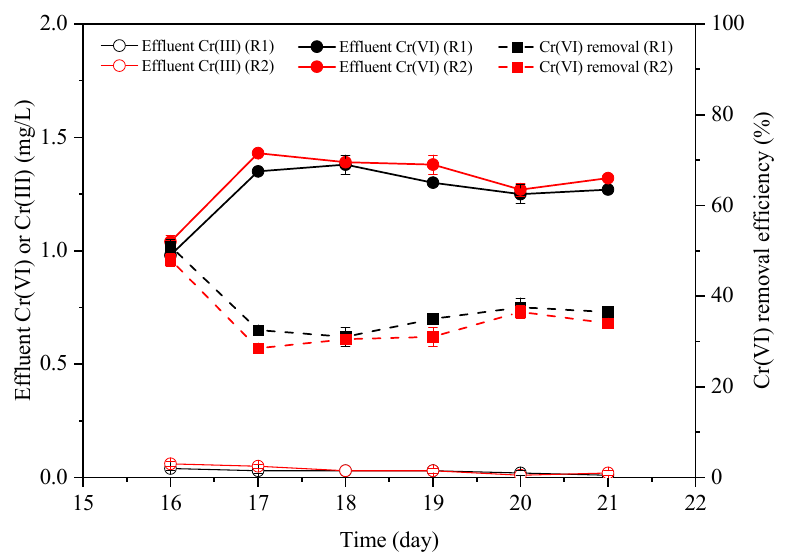
Figure 7. Profiles of the effluent chromium species from R1 and R2, and their Cr(VI) removals during Stage III.